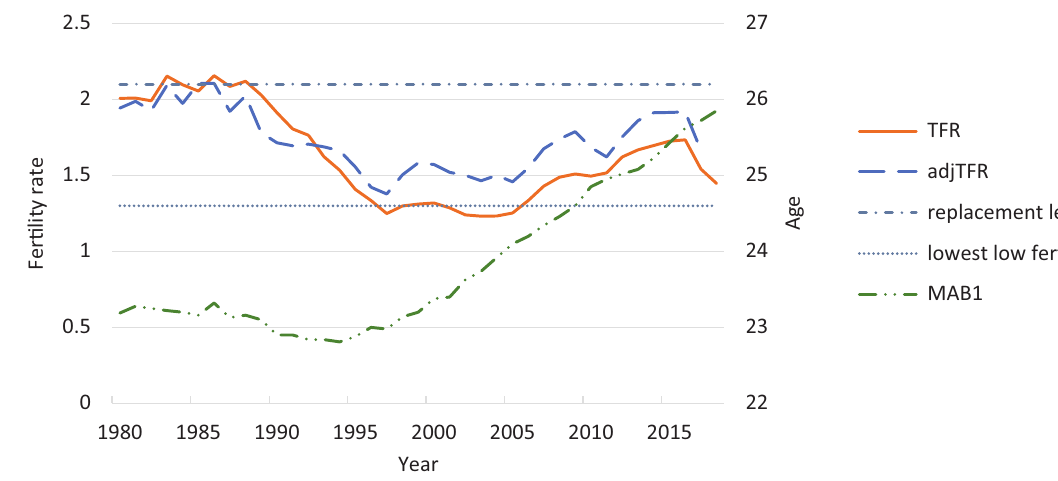
Figure 2. TFR, adjTFR and the mean age at first birth in Belarus, 1980–2018. Social Inclusion, 2022, Volume 10, Issue 3, Pages